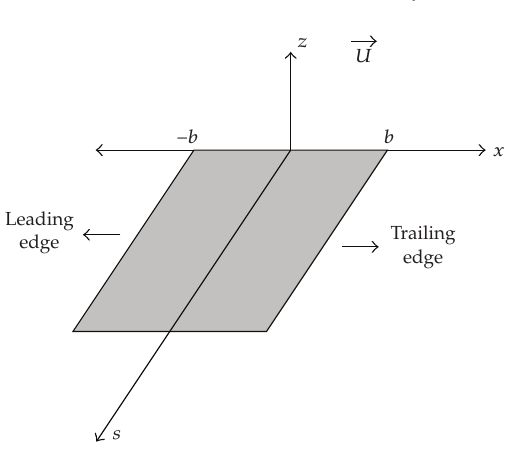
Figure 1: Wing structure beam